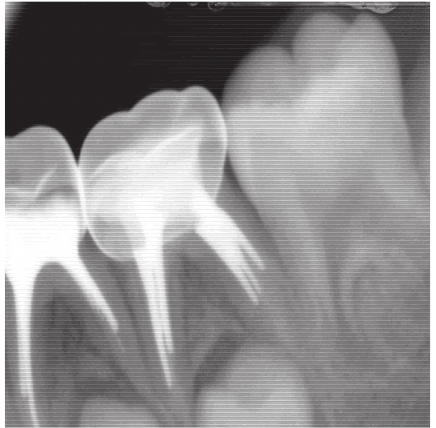
Figure 3: Stainless steel crown in 74 and 75 (RVG